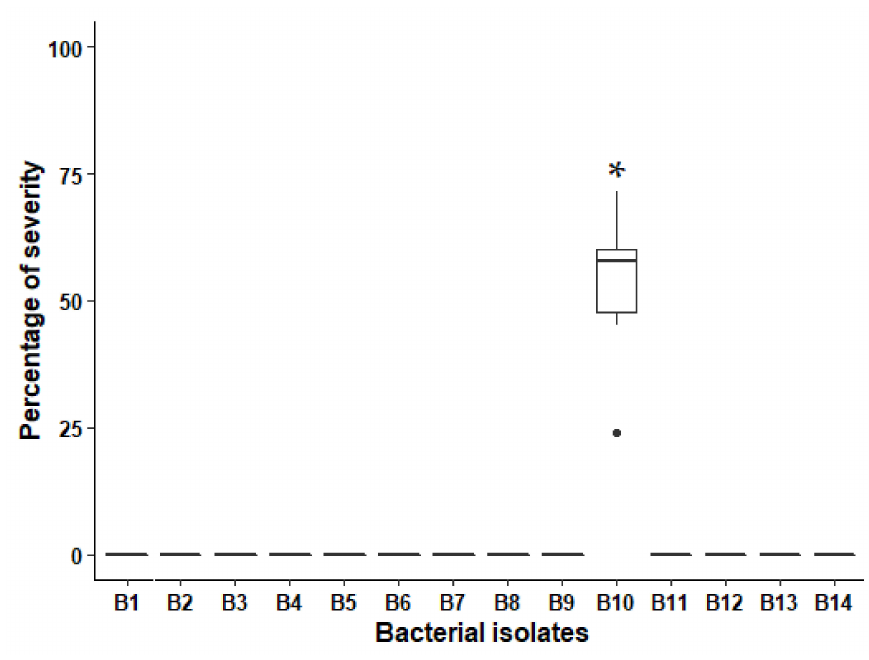
Figure 2. Boxplots of severity percentages calculated for exposed leaves to the fourteen bacterial isolates on Louise bonne cultivar using the spray method. Controls gave similar results as the non-pathogenic isolates (data not shown). Boxes represent the interquartile range, whiskers show the 10th and 90th percentiles and individual outliers are shown as points (Kruskal-Wallis test with * p <